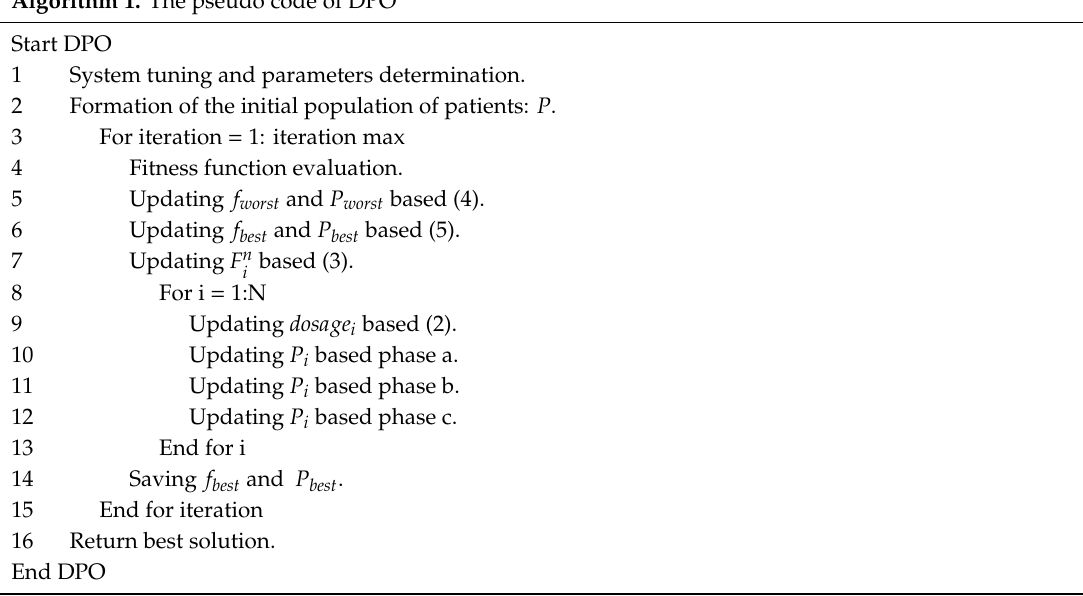
Algorithm 1. The pseudo code of